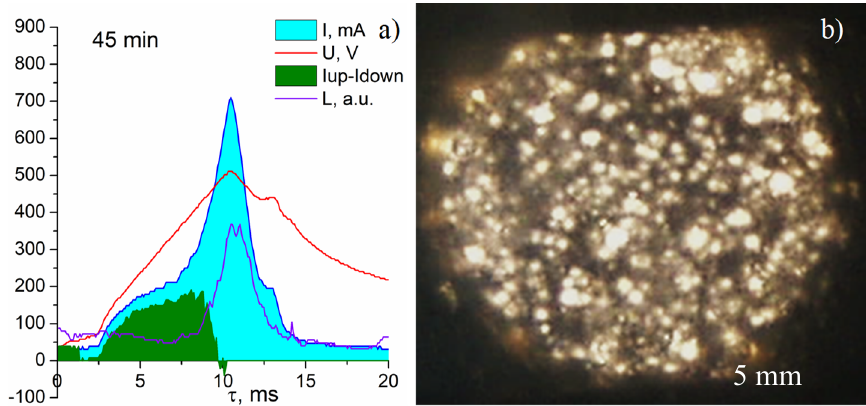
Figure 12. Example of a diagnostic pulse response ( a ) and appearance of the microdischarges ( b ) in course of the PEO process of Al in a silicate–alkaline electrolyte. Legend: I, mA—current; U, V—voltage, Iup–Idown—difference between upward and downward branches of current; L, a.u.—photodiode current.